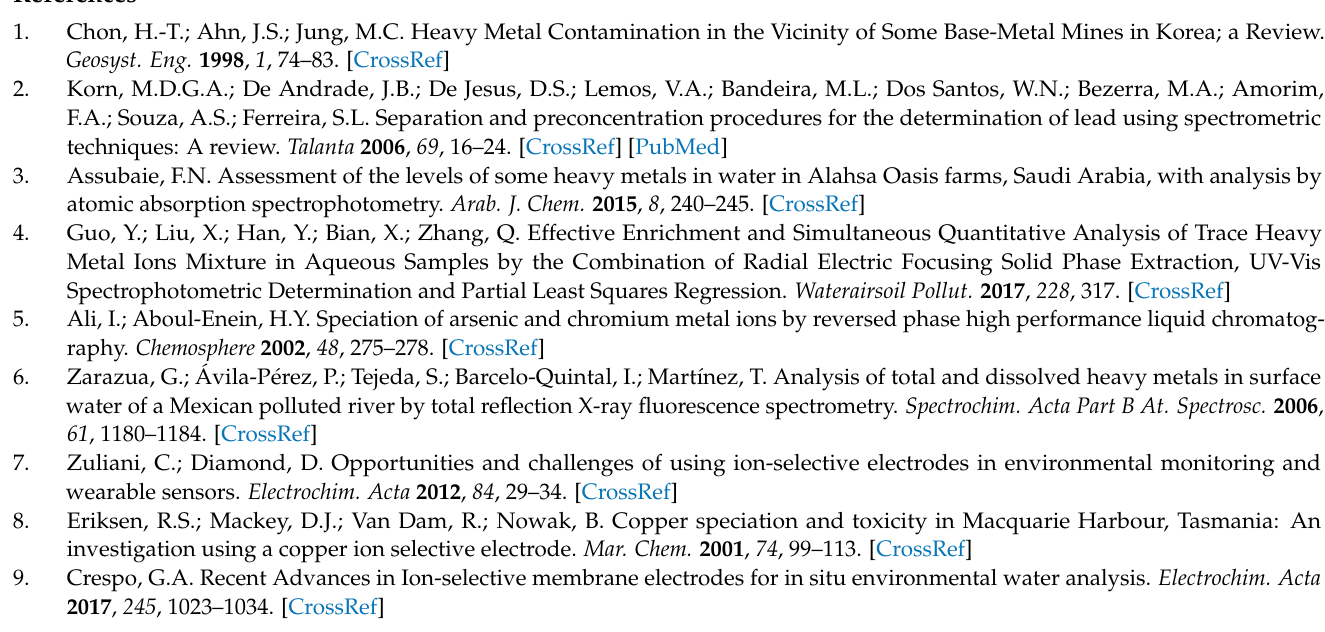
Figure S3: Schematic of a sessile-drop contact angle system, Table S1: Comparison of GC/GR/Pb 2+ - ISEs with different volume of Pb 2+ -ISM characteristics, Figure S4: EMF of GC/GR/Pb 2+ -ISE